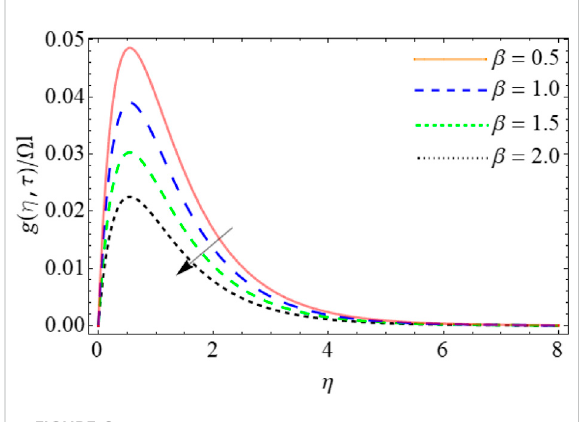
FIGURE 6 Velocity outlines g ( η , τ ) versus Casson fl uid factor β .